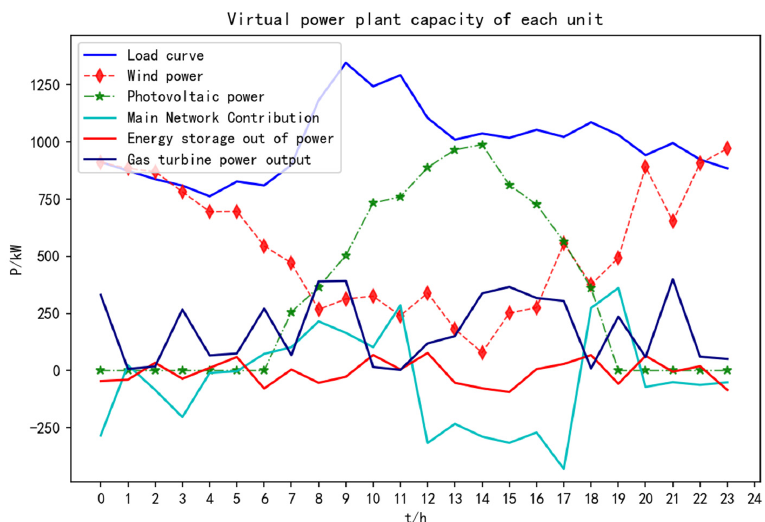
Figure 12. Considering the power output of each component of the VPP under the carbon-trading